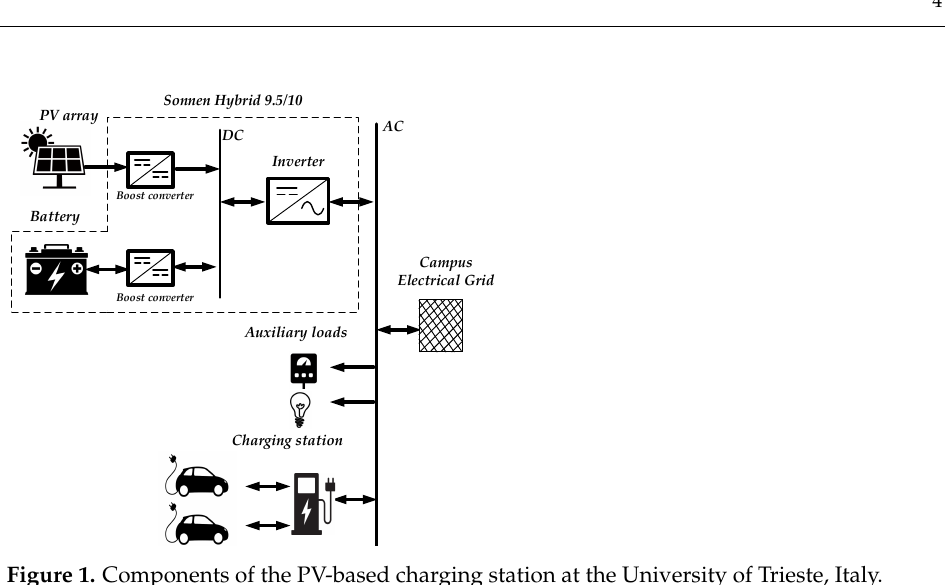
Figure 1. Components of the PV-based charging station at the University of Trieste,